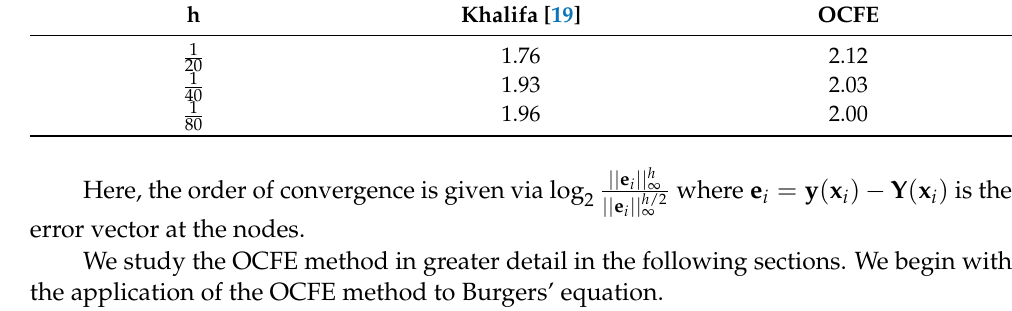
Table 1. Orderof Convergence.